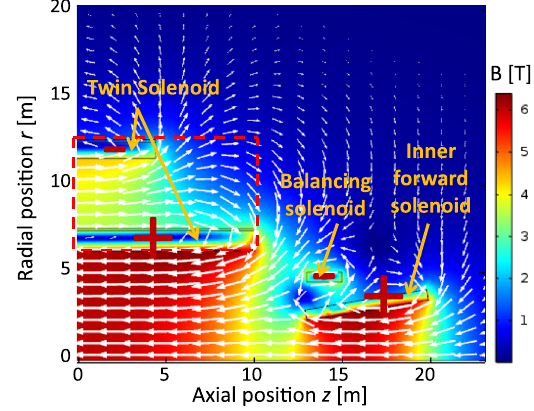
high.FIG. 5. Two-dimensional axisymmetric representation showing half of the twin solenoid and a balanced forward solenoid. The arrows indicate the magnetic field orientation, while the colors indicate the field magnitude. The plus and minus symbols indicate the direction of current within the solenoids. The red dotted lines indicate the common cold